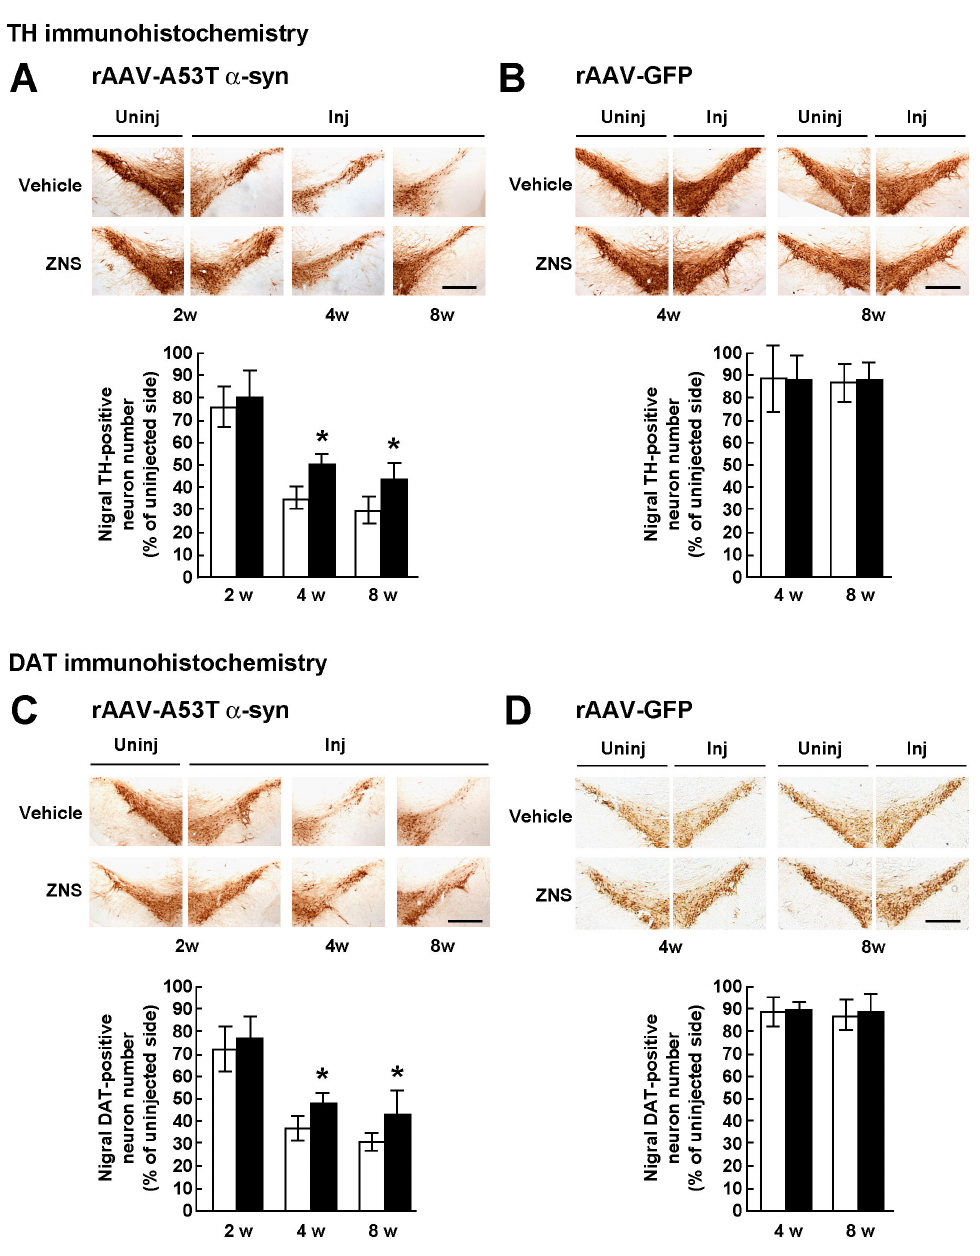
Figure 2. Stereological assessments of the number of nigral dopamine neurons in rats treated with vehicle or ZNS. Rats were unilaterally injected with rAAV-A53T a -synuclein ( A , C ) or rAAV-GFP ( B , D ). The sections were immunostained with antibody for TH ( A , B ) or DAT ( C , D ). In rats injected with rAAV-A53T a -synuclein ( A , C ), photomicrographs show representative immunostainings of the injected and uninjected sides of the substantia nigra at 2 weeks after injection (left panels), and those of the injected sides at 4 weeks (middle panels) and 8 weeks (right panels) after injection. In rats injected with rAAV-GFP ( B , D ), photomicrographs show representative immunostainings of the injected and uninjected sides of the substantia nigra at 4 weeks (left panels) and 8 weeks (right panels) after injection. Scale bars, 0.5 mm. ( A–D ) Graphs show quantitative analysis of TH or DAT-positive nigral neurons. As compared with the vehicle group, ZNS treatment significantly delayed loss of TH-positive nigral neurons at 4 weeks ( P =0.004) and 8 weeks ( P =0.010) after rAAV-A53T a -synuclein injection. Loss of DAT-positive nigral neurons in the ZNS group was also delayed at 4 weeks ( P =0.008) and 8 weeks ( P =0.040) after viral injection. The open bars illustrate the vehicle group and the black bars illustrate the ZNS group. Data represent the mean 6 SD and P -values were estimated by two-way ANOVA, followed by unpaired t test (* P , 0.05). doi:10.1371/journal.pone.0089076.g002 striatal fibers between the vehicle and ZNS groups at 4 and 8 weeks after viral injection (Figure 3D).